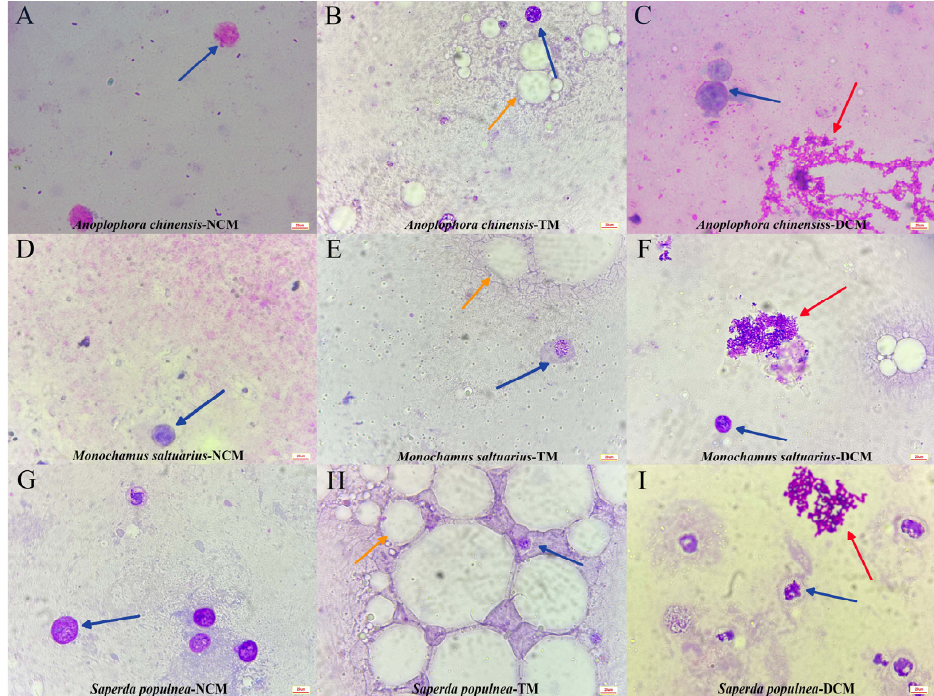
Figure 4. Microscopic examination of smears from three cerambycid beetle species for different collection methods under a 100× oil immersion lens. Blue arrows point to haemocytes; yellow arrows point to fat cells; red arrows point to blood coagulation. ( A – C ): Microscopic examination of smears from Anoplophora chinensis for NCM, TM and DCM under a 100× oil immersion lens. ( D – F ): Microscopic examination of smears from Monochamus saltuarius for NCM, TM and DCM under a 100× oil immersion lens. ( G – I ): Microscopic examination of smears from Saperda populnea for NCM, TM and DCM under a 100× oil immersion lens.